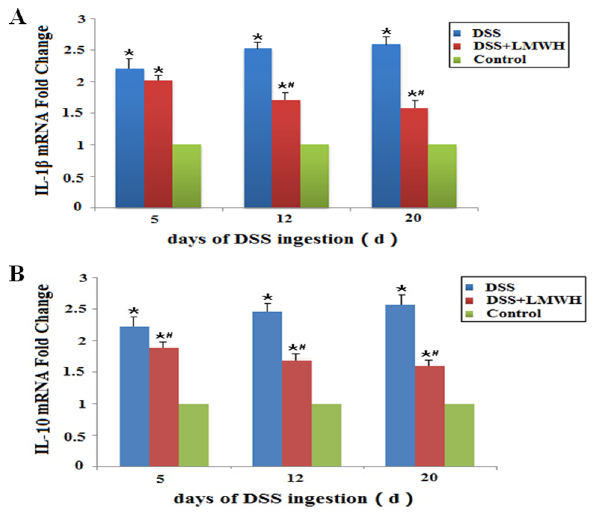
Figure 6. mRNA expression of IL-1 b and IL-10 in the intestinal mucosa. The mRNA levels of IL-1 b (A) and IL-10 (B) in the intestinal mucosa were detected by qRT-PCR on the indicated day, respectively (n=18/group). * P , 0.05 vs. the control; # P , 0.05 vs. the DSS